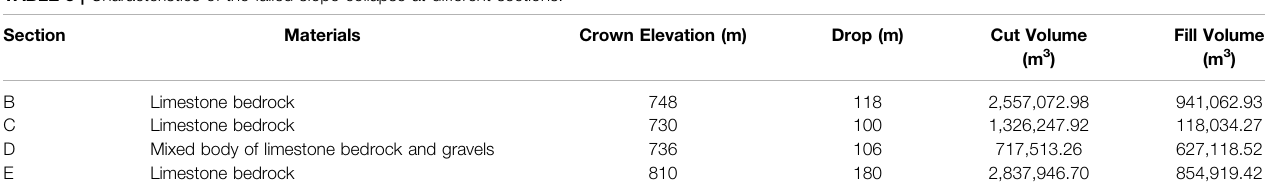
TABLE 3 | Characteristics of the failed slope collapse at different